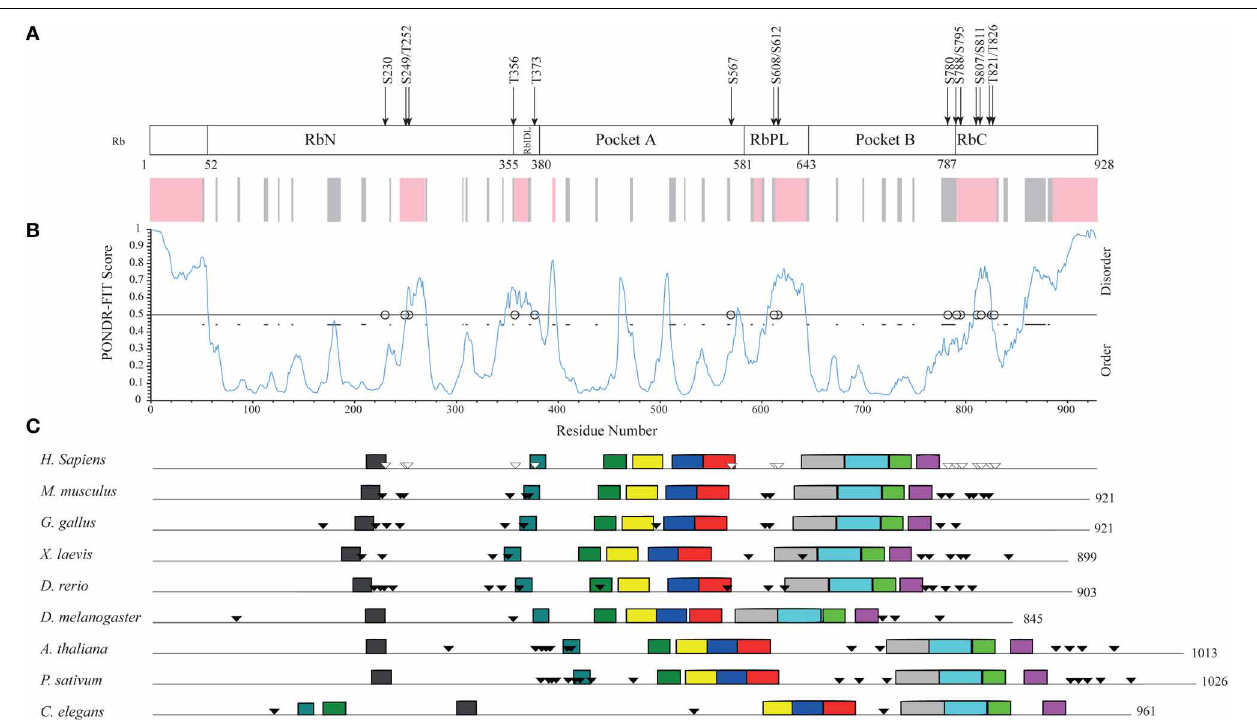
FIGURE 4 | Structural organization of human Rb along the evolution of multicellular Eukarya. (A) The domain organization of human Rb and a scheme summarizing the structurally determined regions, as obtained by a literature survey. Gray shadow indicates experimentally determined coiled coil regions, pink shadow indicates unsolved 3D structures. (B)